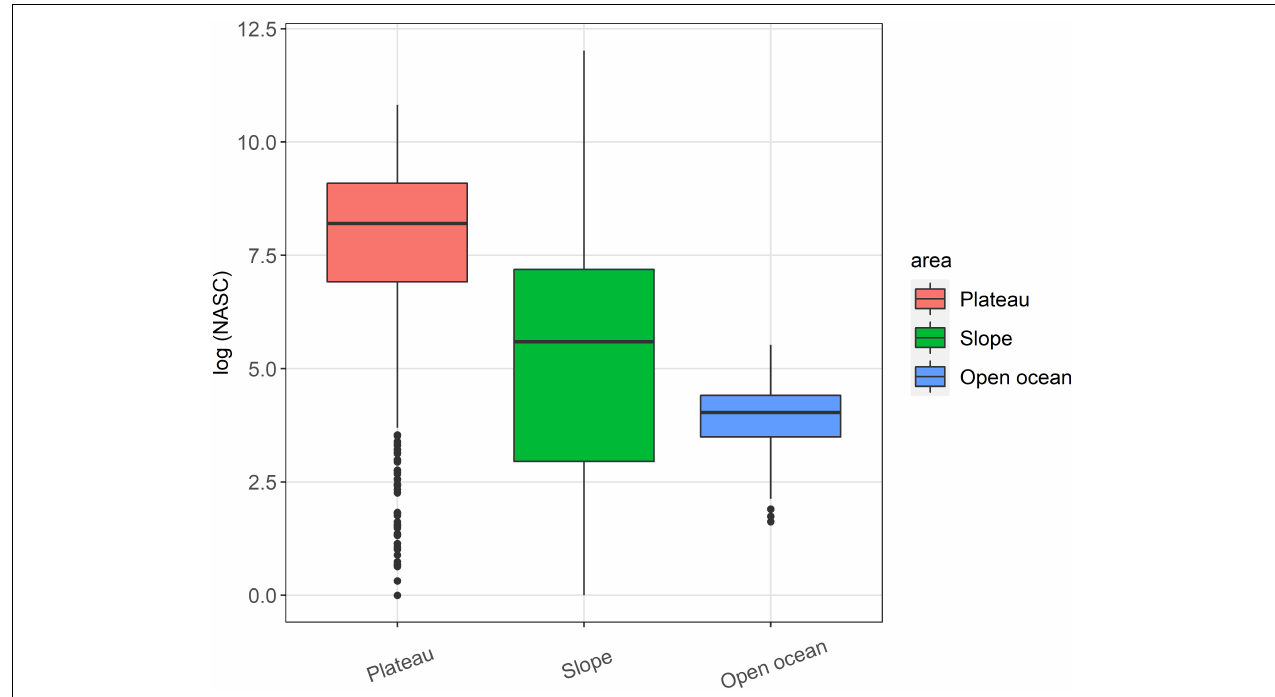
FIGURE 2 | Boxplot of the log-transformed Nautical Area Backscattering Coefficient (NASC) calculated over the plateau and slope of the seamounts and at the open ocean area. Lower and the upper hinges correspond to the first and third quartiles. Dots at the end of the boxplot represent